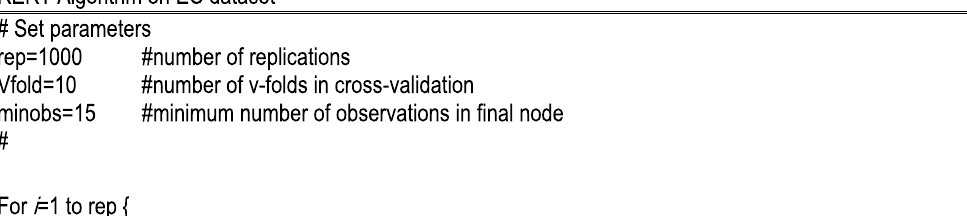
FIGO stage as dependent variable and 11 variables in the dataset as covariates which corresponds to the preoperative clinical characteristics [HE4, CA125, age (in years), BMI, number of children, menopause status, contraception, HRT, hypertension, grading from biopsy, clinical stage (pre-surgical)]. For each of the eleven variables we obtained, through the use of Random Forest, a measure of importance that allowed us to identify the drivers of the surgical FIGO stage prediction. Using the same variables as in the first step, ( ii ) we grew an ensemble of 1000 Regression Trees extracting the most representative pruned tree from the black-box obtained. The pruning method permits to avoid the typical overfitting problem of Regression Trees 15 . The final graphic representation gives clinicians a flow-chart with cut-off values enabling a major comprehension of the phenomenon under inspection. Patients and samples.